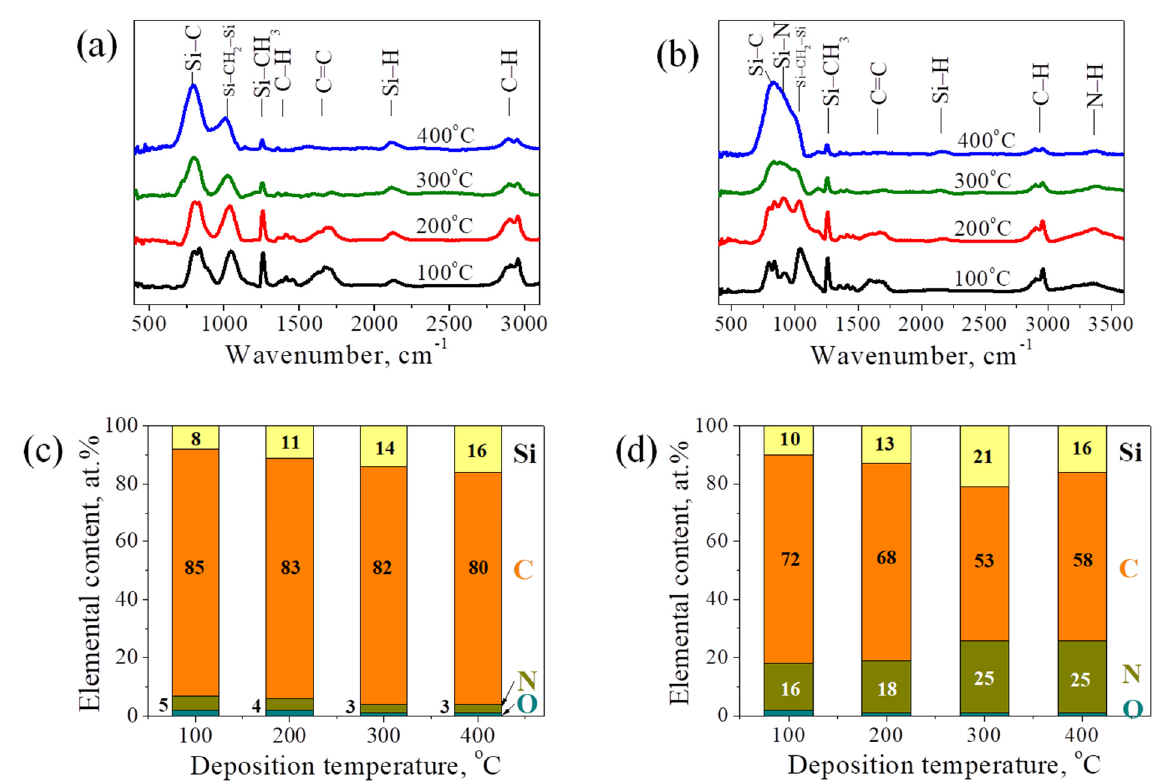
Figure 2. FTIR spectra ( a , b ) and EDX elemental composition ( c , d ) of SiC:H (SiCN:H) films deposited using TMS/He ( a , c ) and TMS/NH 3 ( b , d ) gas mixtures.